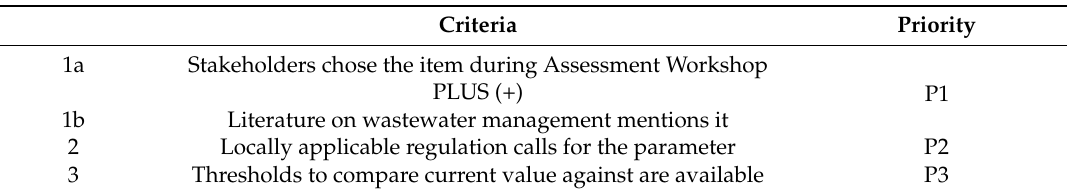
Table 2. Criteria used to prioritize the data items in the extended dataset framework and to create a site-specific dataset